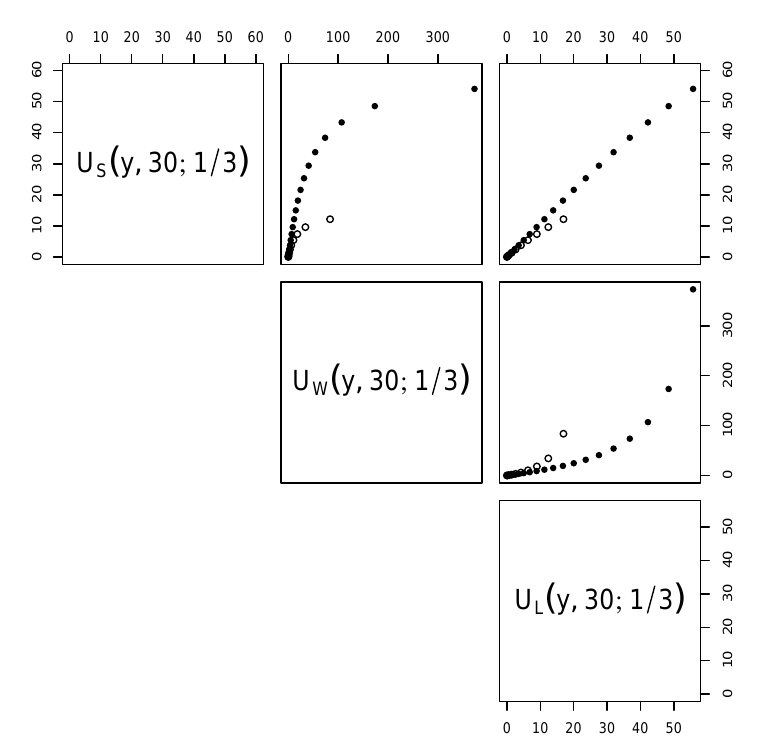
, squared Wald, U , and log-likelihood, S W = 1 / 3. The 0